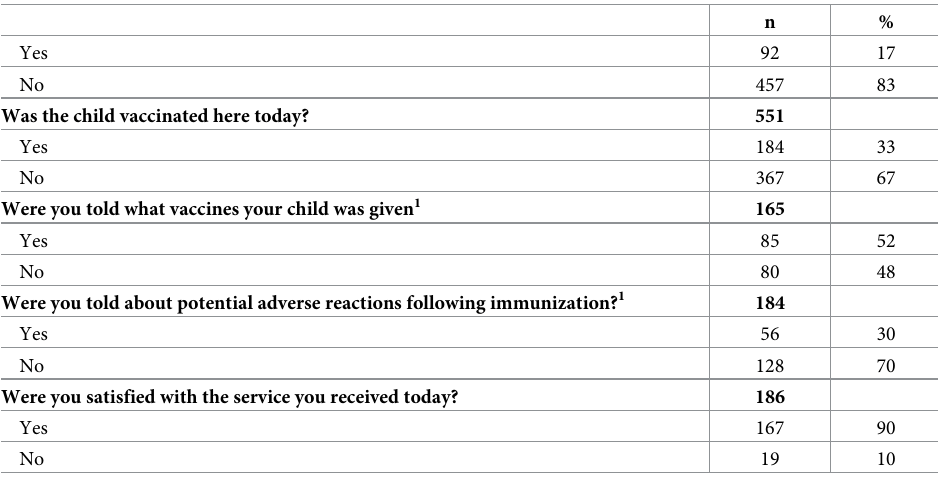
(Table 4). For multi-dose vaccine series, timeliness generally decreased with later doses. Simi- larly, timeliness of MCV, due to be given at 9 and 18 months, dropped nine percentage points from the first dose (75%; 127/169) to the second dose (66%;